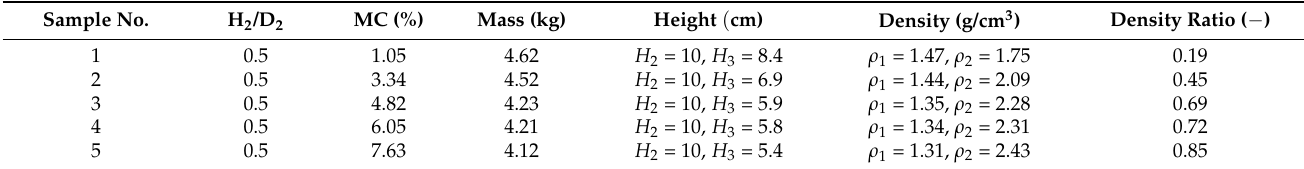
Table 1. Five samples of sandy loam soil measured at different moisture